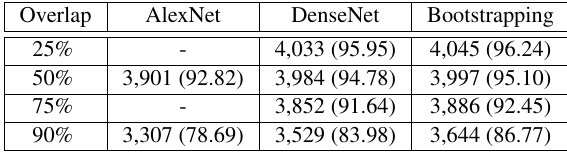
Table 1. Number of detected buildings and PR break-even point at different building overlaps on the test set. The last column denotes improved results after bootstrapping